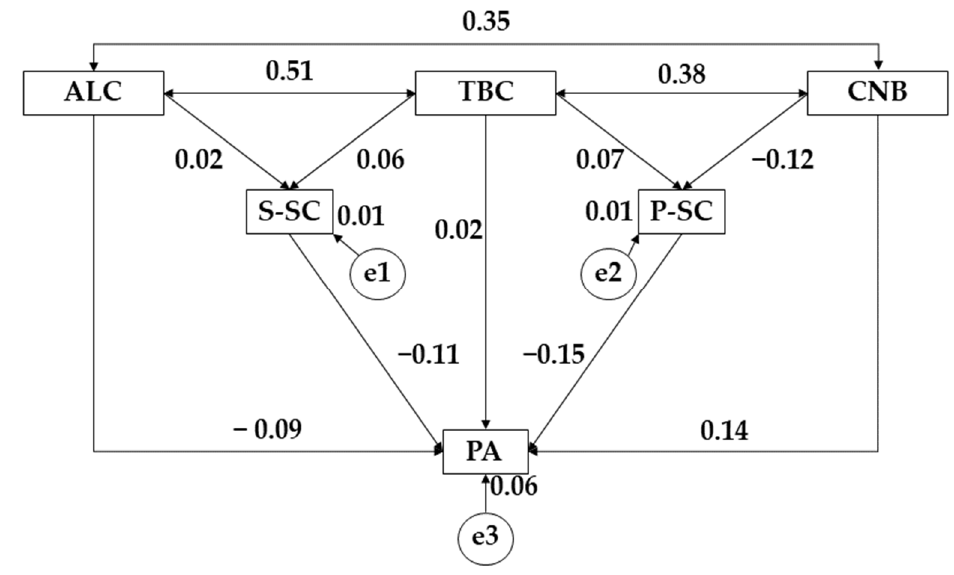
Figure 3. Proposed structural equation for the male population. Note: Alcohol (ALC); tobacco (TBC); cannabis (CNB); social self-concept (S-SC); physical self-concept (P-SC); physical activity (PA). Table 5. Structural model for male